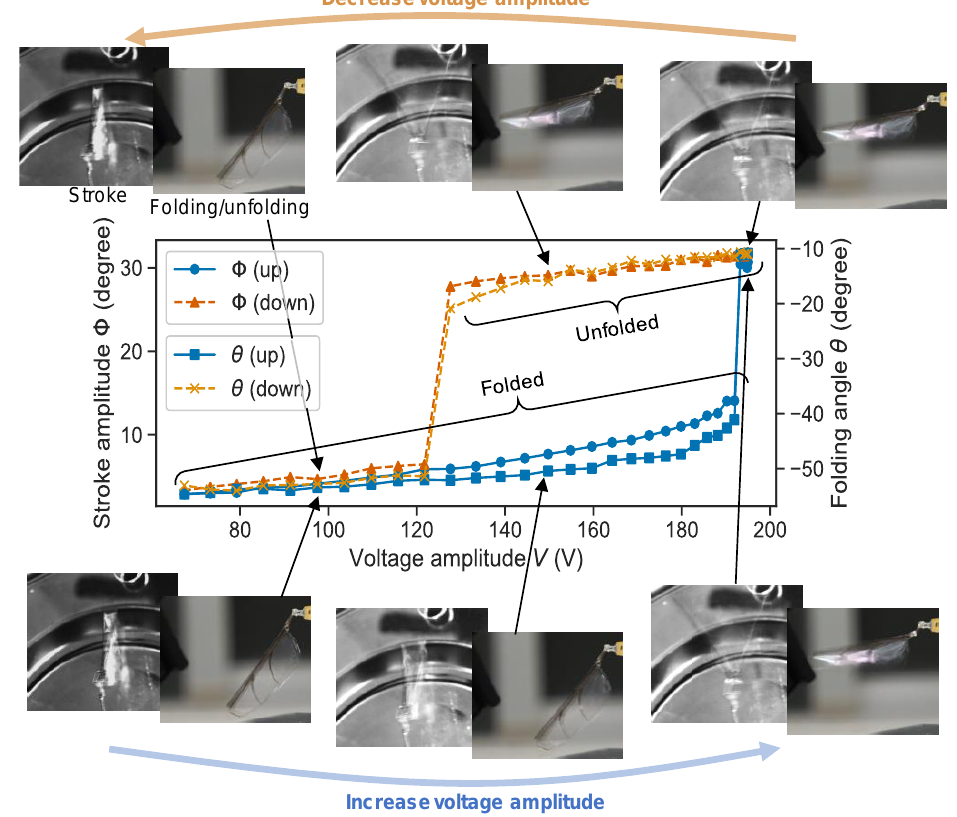
Figure 5. Relationship among the applied voltage, stroke amplitude, and folding angle at a frequency of 95 Hz.